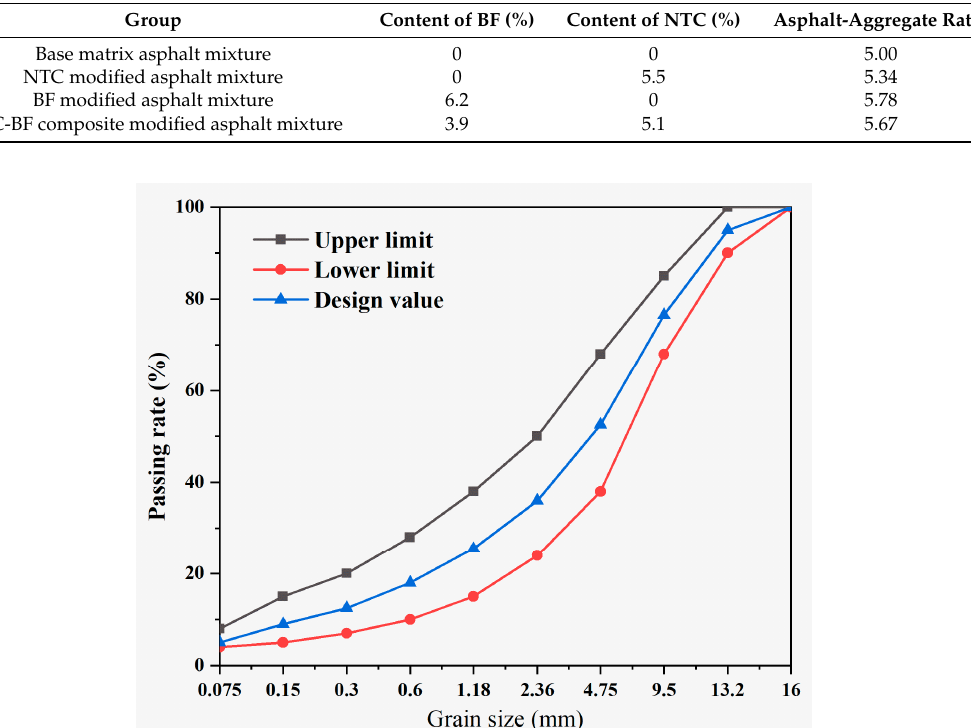
Figure 3. Gradation of test asphalt mixture.